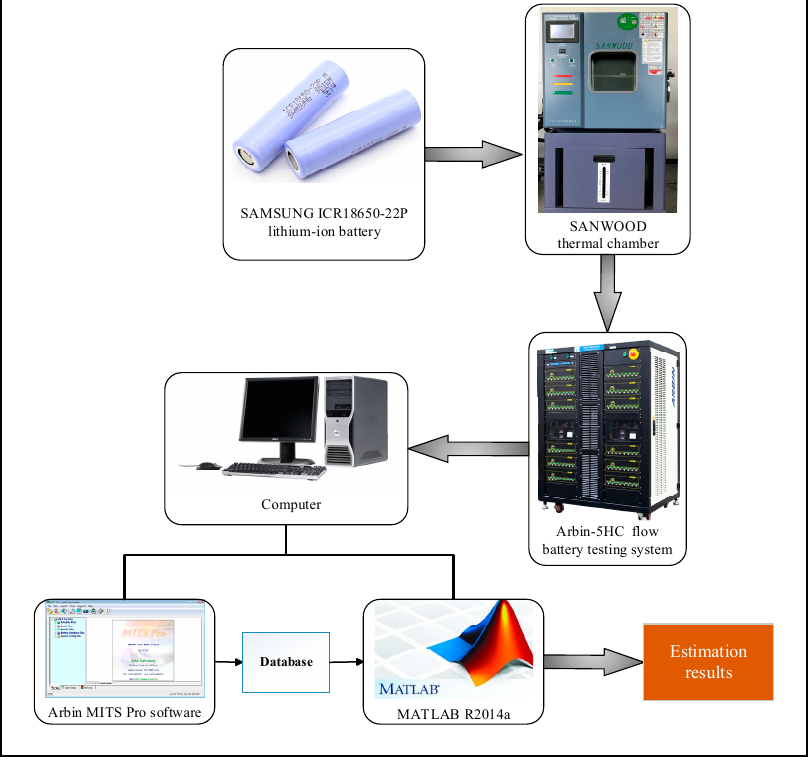
Figure 4. Diagram of the workbench.